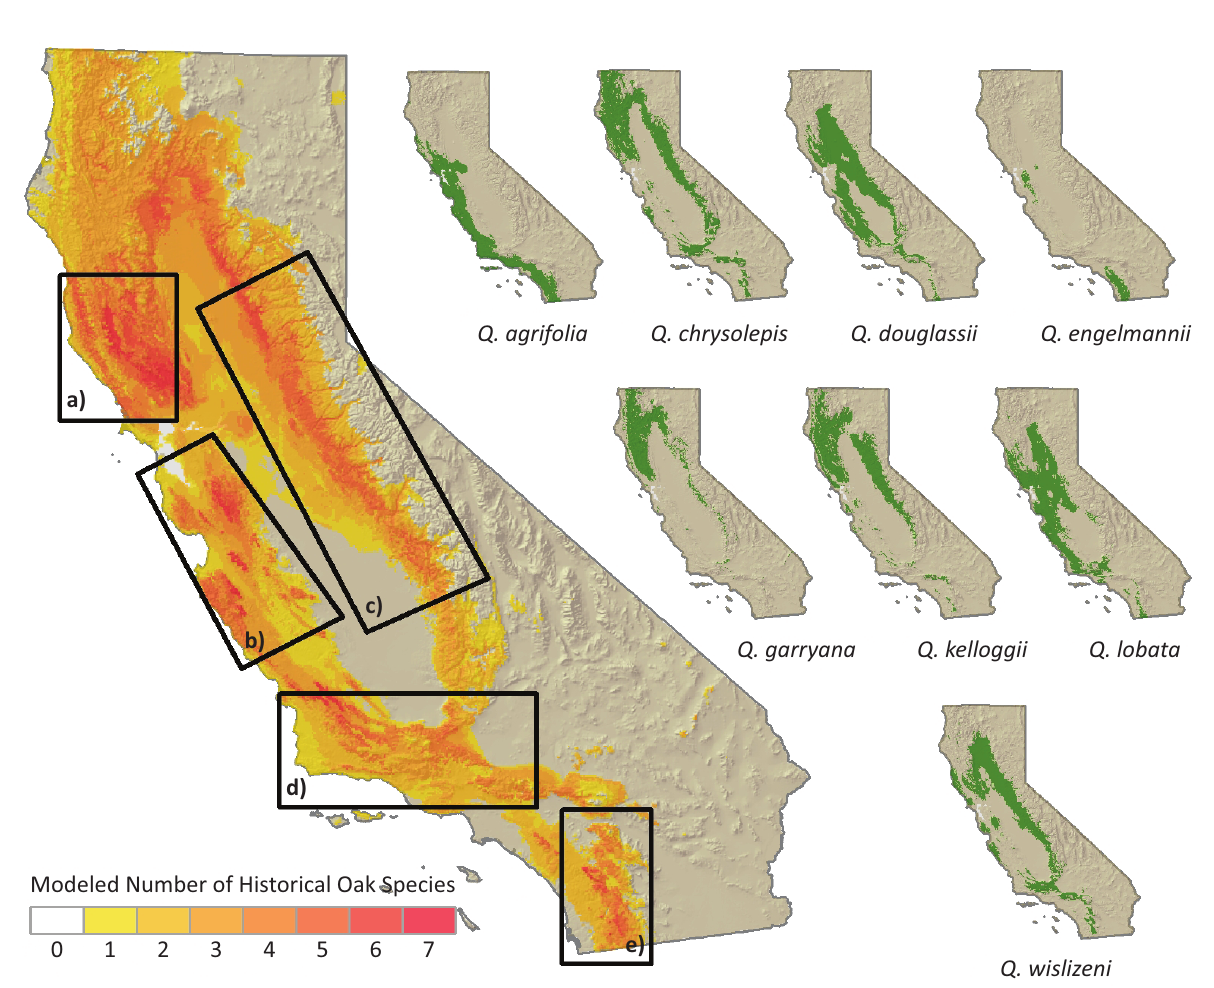
Figure 2. Modeled Number of Historical Oak Species: a) North Coast Range, b) South Central Coast Range, c) Sierra Nevada Foothills, d) Transverse Ranges including the Tehachapi Mountains, and e) Peninsular Ranges. Individual binary maps of eight modeled oak distributions are also